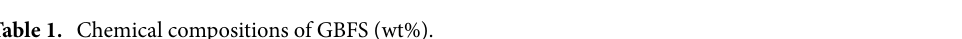
Table 1. Chemical compositions of GBFS